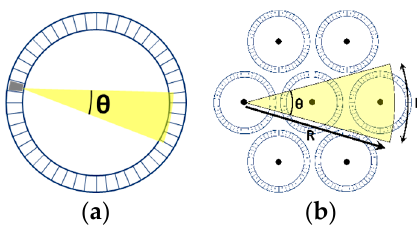
Figure 7. ( a ) Data Center cluster hosting 48 racks and OBS element with steering angle θ ; ( b ) The coverage of the FSO node for inter-cluster connection. Photonics 2018 , 5 , x FOR PEER REVIEW